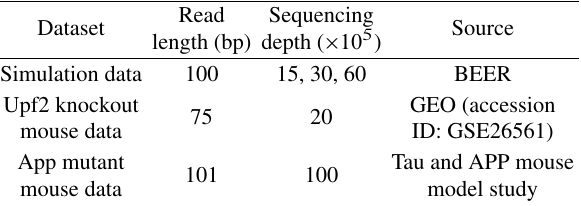
Table 2 Description for three mouse RNA-Seq